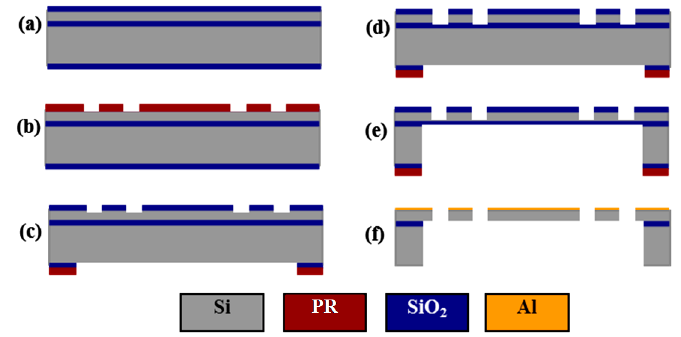
Figure 5. Process flow: ( a ) deposition of plasma-enhanced chemical vapor deposition (PECVD) SiO 2 hardmask layers; ( b ) patterning of the front side SiO 2 layer; ( c ) patterning of the backside SiO 2 layer; ( d ) deep reactive-ion etching (DRIE) of the device layer; ( e ) DRIE of the handle layer; ( f ) SiO 2 buffered hydrofluoric acid solution (BHF) release-etching, isopropyl alcohol (IPA) rinsing, IPA drying, and evaporation of Al layer.